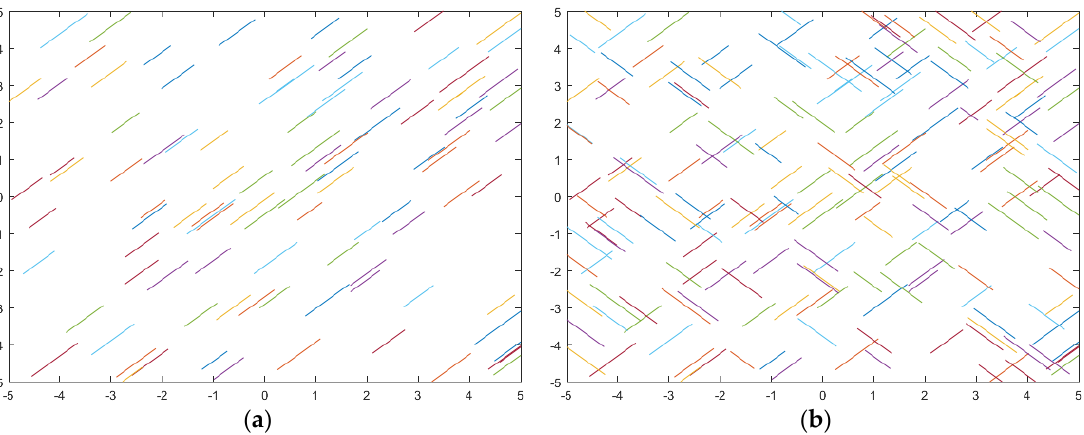
Figure 2. Natural joints that were generated by the Monte Carlo method (x-axis and y-axis are the horizontal and vertical dimensions (m); fracture trace length: 1.0/0.2; fracture spacing: 2.0/0.5; Group 1 fracture dip angle: 45°/0.1°; Group 2 fracture dip angle: 135°/0.1°). ( a ) Group 1 fracture, ( b ) Group 2 fracture.